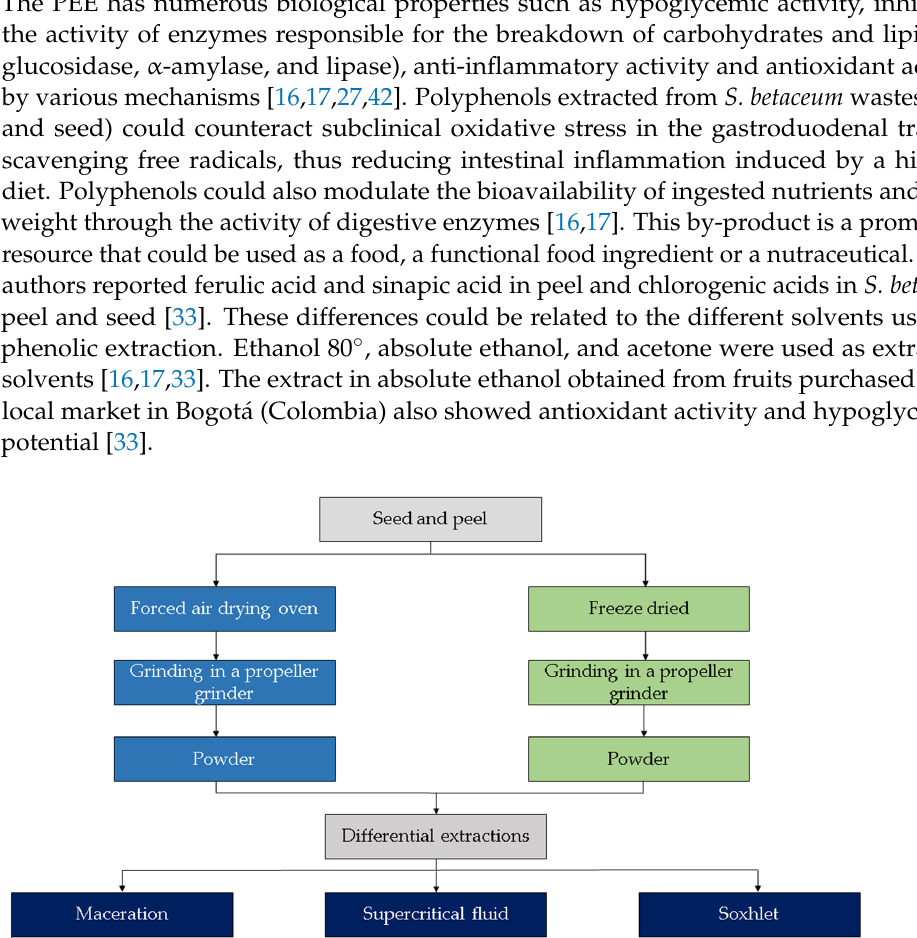
Table 4. Phenolic compounds identified in seeds and peel of S. betaceum fruits by HPLC MS/MS. S. betaceum by ‐ Products